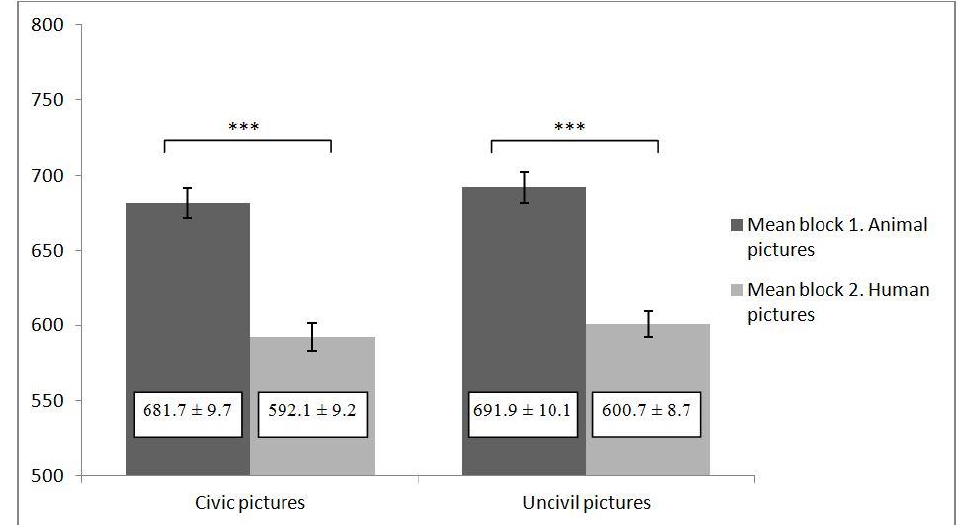
Figure 1. Means ± standard error for reaction times (in milliseconds) of block 1 and 2 in study 1. *** indicated p < 0.001. *** indicated p <